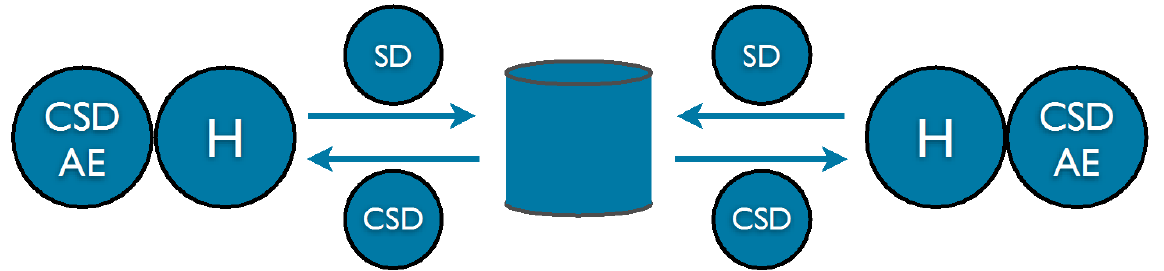
Figure 3. Collective sensor data augmented experience, CSDAE (H = human, SD = sensor data, CSD = collective sensor